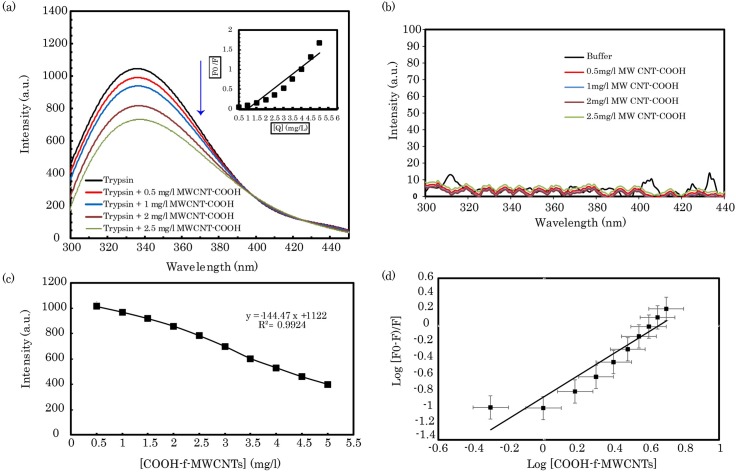
(a) Fluorescence spectra of the COOH-f-MWCNTs-pTry system. Conditions: λex = 280 nm, pH 8.0; C
trypsin 2.0 × 10−5 M, CCNTs are in the total volume of the reaction mixture; pH 8.0, T = 298 K. (b) Emission spectra of COOH-f-MWCNTs systems alone. (c) The plot of fluorescence quenching for trypsin with the concentration of COOH-f-MWCNTs. (d) The logarithmic plot of trypsin with the concentration of COOH-f-MWCNTs. Data are shown as mean values ± S.D.